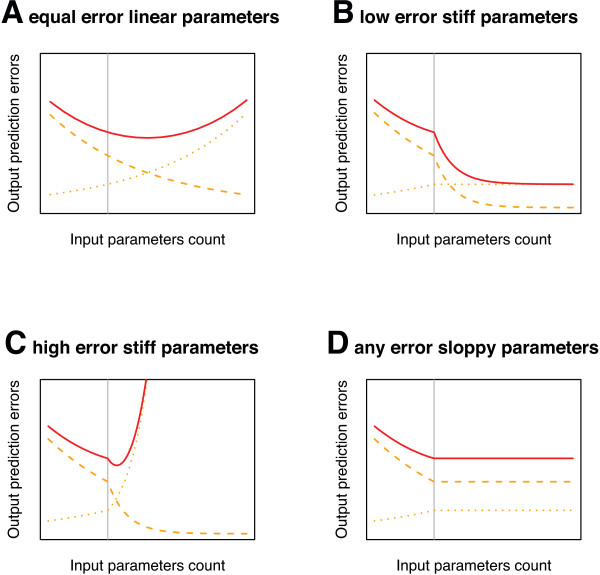
The trade-off between systematic and random errors in modelling. The number of input parameters is an indicator of model complexity and the sum of output prediction errors denotes the accuracy of the model with a particular parameter combination. The dotted line is the total random error introduced by badly estimated input parameter values, the dashed line is the total systematic error that comes from using a poor model with too few input parameters and the solid line is the combined overall error. See the text for more explanations. Note that sloppy parameters can become stiff and vice versa if the underlying model logic is changed to accommodate new parameters. All parameters left of the vertical grey line behave in the same simple linear way as depicted in (A).